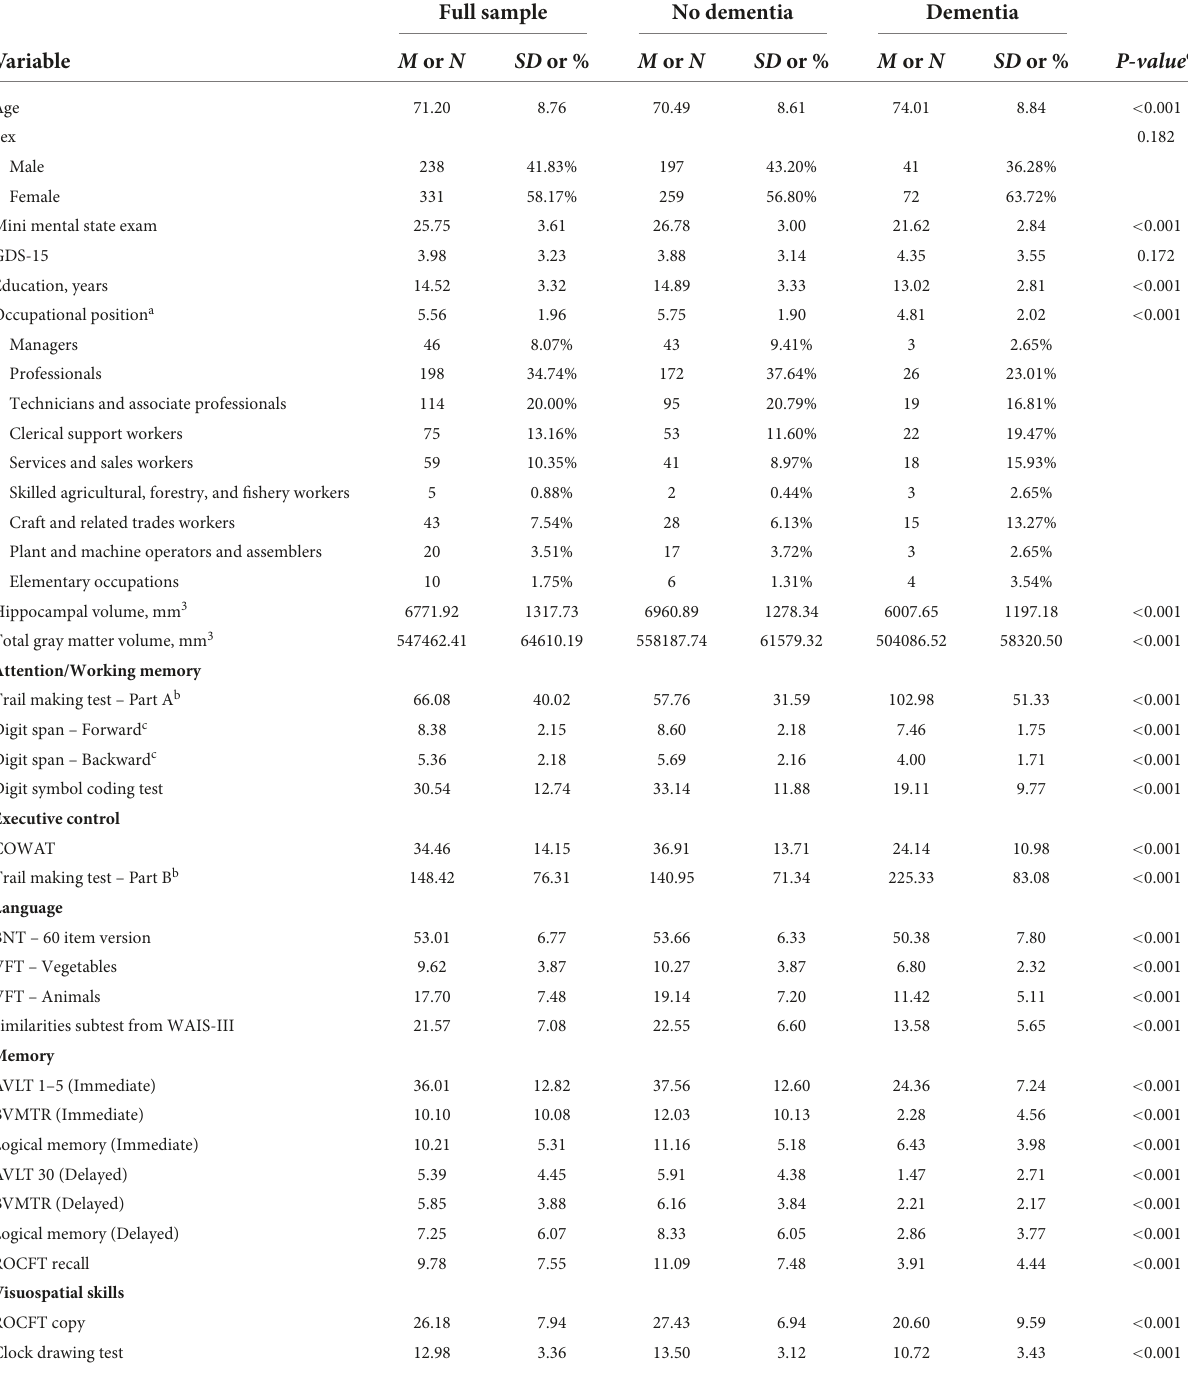
TABLE 1 Descriptive statistics of study variables for the full sample and by